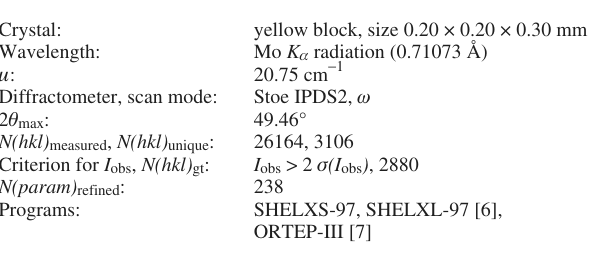
Table 1. Data collection and handling.